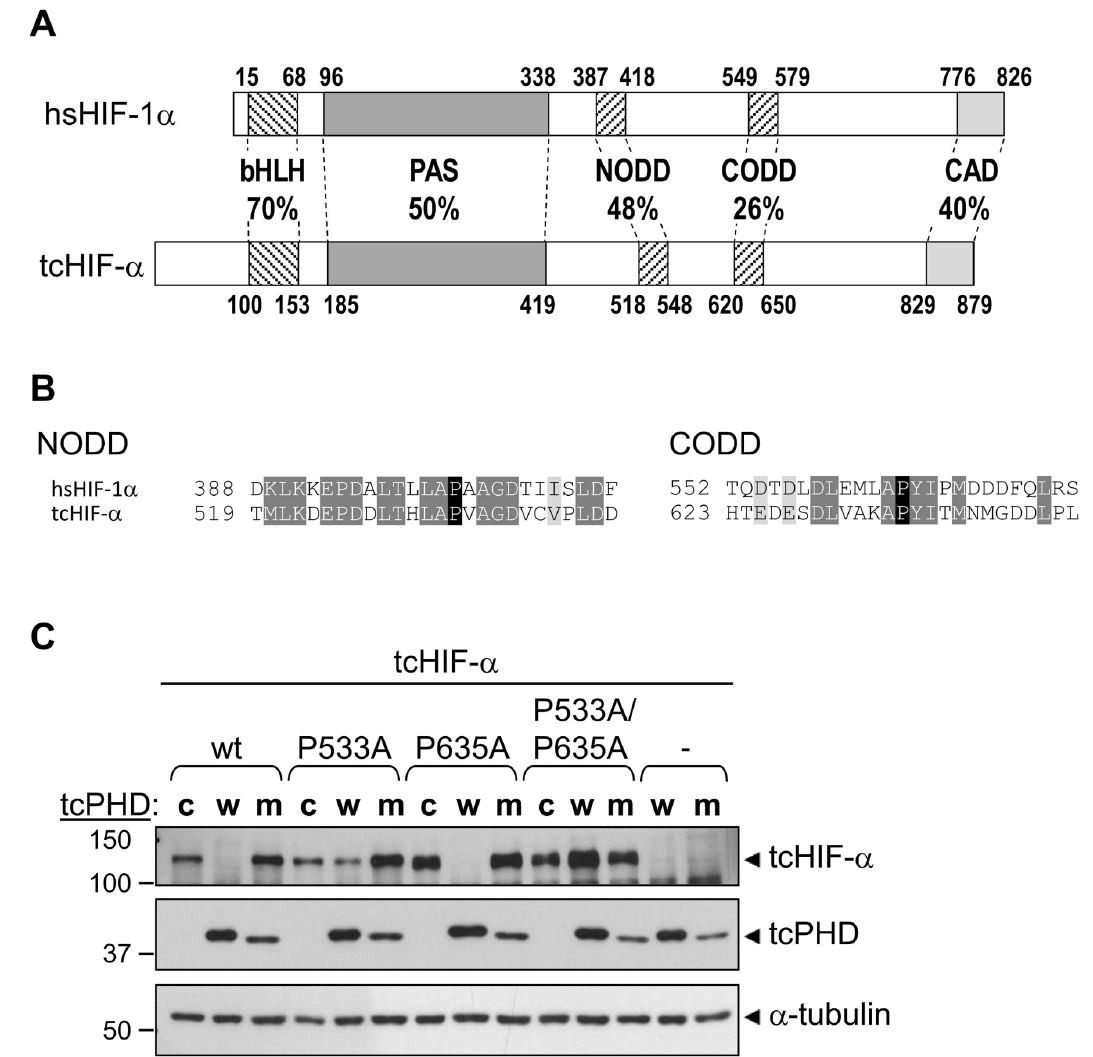
Fig 6. T. castaneum PHD mediates degradation of T. castaneum HIF- α . (A) Comparative domain structure of hsHIF-1 α and tcHIF- α showing the percent identity of amino acid sequence in conserved regions, including the basic helix loop helix (bHLH), Per ARNT Sim homology domain (PAS), N- and C-terminal oxygen-dependent degradation domains (NODD and CODD) and C- terminal activation domain (CAD). Amino acid numbers at the start and end of each domain are shown. (B) The NODD and CODD amino acid sequences from tcHIF- α are shown aligned with the equivalent domains from hsHIF-1 α . Conserved and similar residues are indicated by dark and light grey highlights, respectively, and the hydroxylated prolines (Pro533 in the NODD, Pro635 in the CODD) are in black. Amino acid numbers are to the left of each sequence. (C) The ability of tcPHD to facilitate degradation of tcHIF- α was assessed in mammalian cells. pEF-IRES-myc-6His-Puro6 plasmids, either empty (“-“) or encoding wild-type (wt) tcHIF- α , tcHIF- α single proline to alanine mutants P533A or P635A, or tcHIF- α double mutant P533A/P635A were transiently transfected into HEK293T cells along with pcDNA3.1 encoding a V5 epitope tag and wild-type tcPHD (“w”), catalytic mutant tcPHD H321A (“m”) or non-specific control Aryl Hydrocarbon Receptor aa 84–287 (“c”). Cells were then incubated for 8 hrs in normoxia. Levels of tcHIF- α and tcPHD protein in cell extracts were subsequently analysed by western blotting for myc and V5 epitope tags, respectively. α -tubulin served as a loading